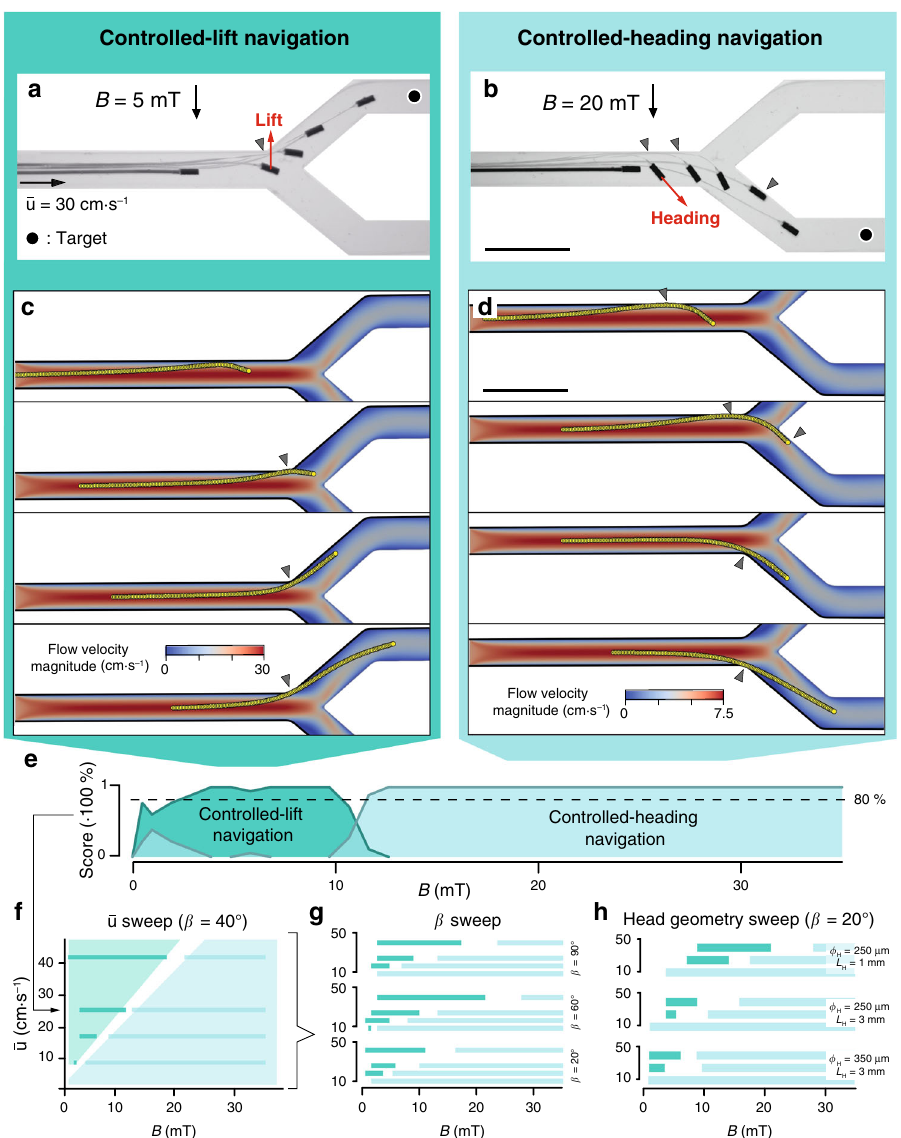
Fig. 5 Navigation strategies to deploy μ -probes at target locations in the vasculature. a , b Overlay of time-lapse images showing controlled transport of µ -probes to the target location (black dot) using ( a ) CL and ( b ) CH navigation. At lower B , CL navigation exploits the lift force emerging from the elastohydrodynamic coupling between the fl ow and the fl exible structure. Lift force drifts the entire device into the upper daughter vessel (left). At higher B , the stronger magnetic torque enables setting of a course along which the µ -probe is transported by the fl ow (right). c , d Simulations showing the successful navigation of the structure adopting ( c ) CL or ( d ) CH methods. e A score plot quantifying the statistics of the success rate for each navigation strategy at (cid:1) (cid:3) different B and constant fl ow velocity (cid:1) u ¼ 26cm (cid:2) s (cid:3) 1 . The μ -probe was placed in the middle of a 2 mm × 2 mm channel bifurcating at an angle β = 40°. Navigation tests were repeated three times for both daughter arteries with three different µ -probes ( n = 18). f Phase diagram illustrating the most favourable navigation strategy for given (cid:1) u and B . The values are binarized at an 80% con fi dence. g Effects of β on the success of each navigation strategy. h The in fl uence of the magnetic head geometry on the navigation score. Scale bars, 5